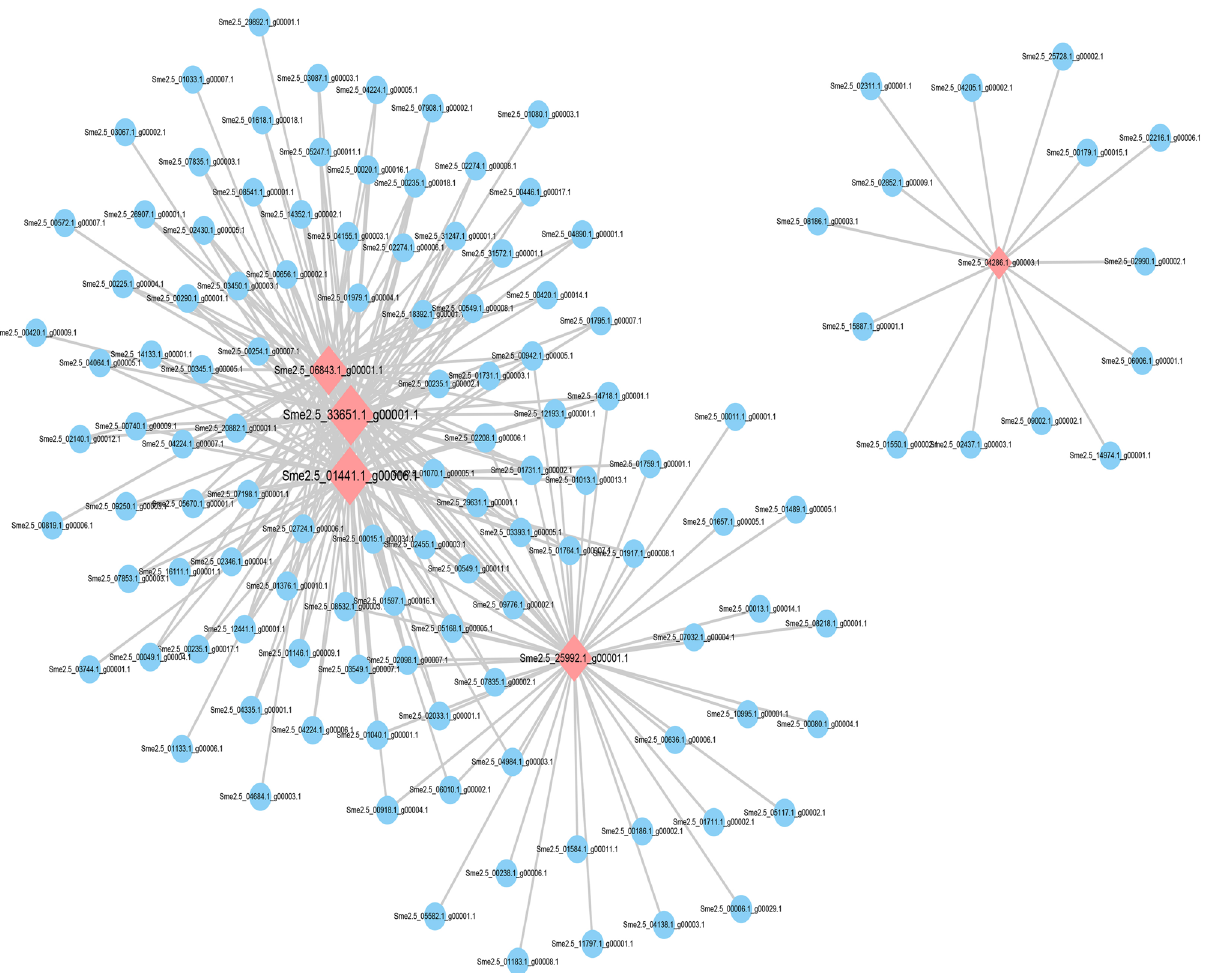
Figure 10. mRNA regulatory network associated with polyphenol oxidase (PPO) genes. Cytoscape v3.6.0 (https:// cytos cape. org/) was used to create the